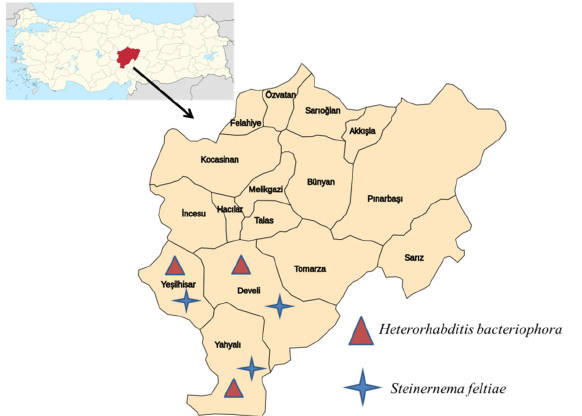
Figure 1. Map of Kayseri Province showing districts where entomopathogenic nematodes were found. Table 1. Soil samples collected from apple-growing areas of Kayseri Province.